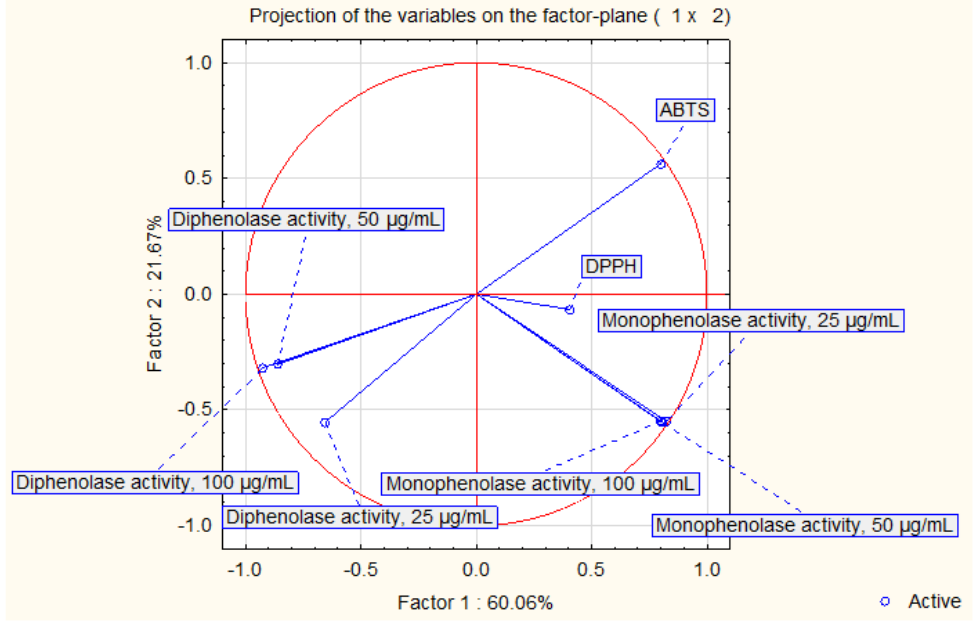
Figure 2. Projection of the variables on the factor plane in a two-component model.